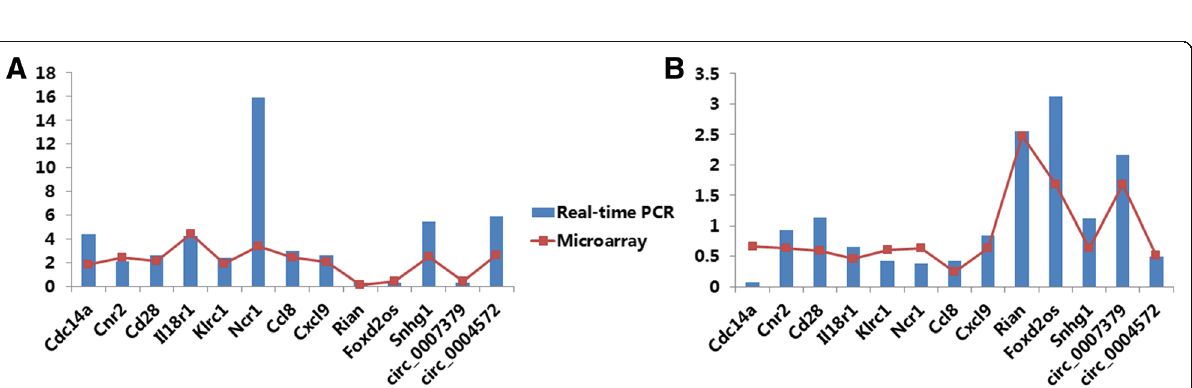
Fig. 7 Validation of representative RNAs. The x-axis represents RNA names, and the y-axis represents RNA fold changes based on average expression values. Blue bars represent data yielded by real-time qPCR, and red line with points represent data obtained by microarray. a MCD vs normal groups, ( b ) QG vs MCD